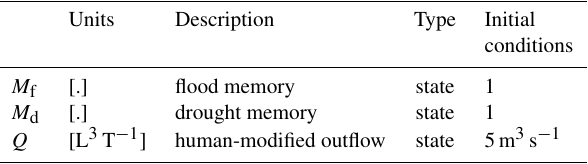
Table 1. Summary of time-varying variables of the stylized model and initial conditions used in the experiment presented here.